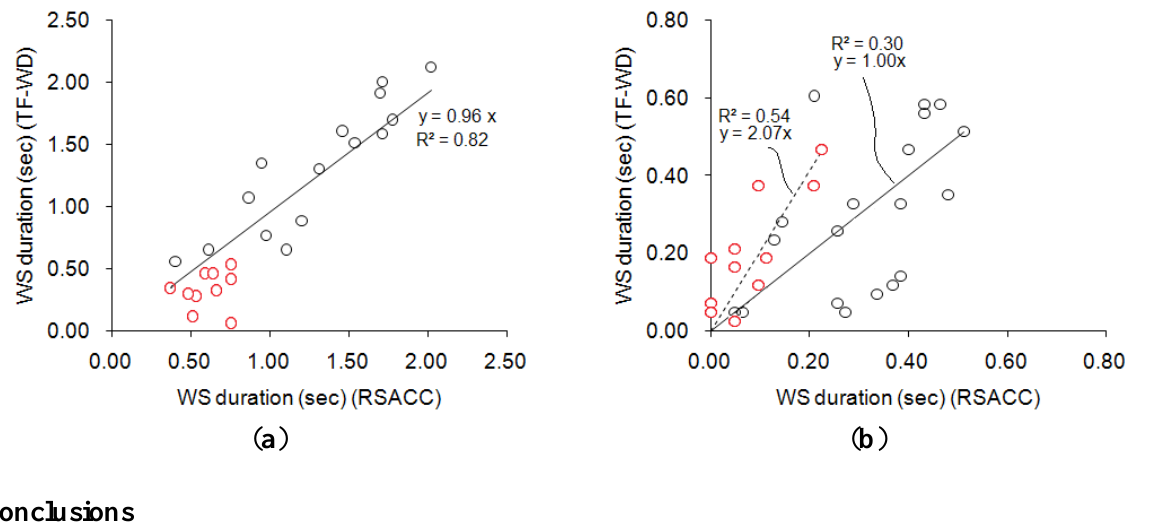
Figure 8. Comparison of WS durations determined using RSACC and TF-WD. ( a , b ) Results for wheeze group and non-wheeze group, respectively. Red circles in (a) indicate cases of wheeze with two-thirds assent. Red circles in (b) indicate cases of non-wheeze with complete